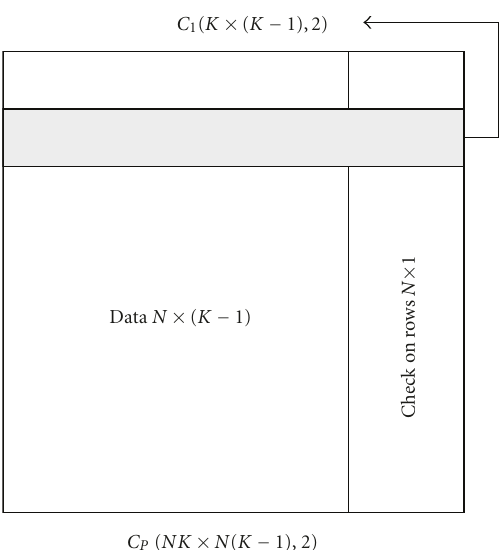
Figure 2: One-dimensional single parity check product code.